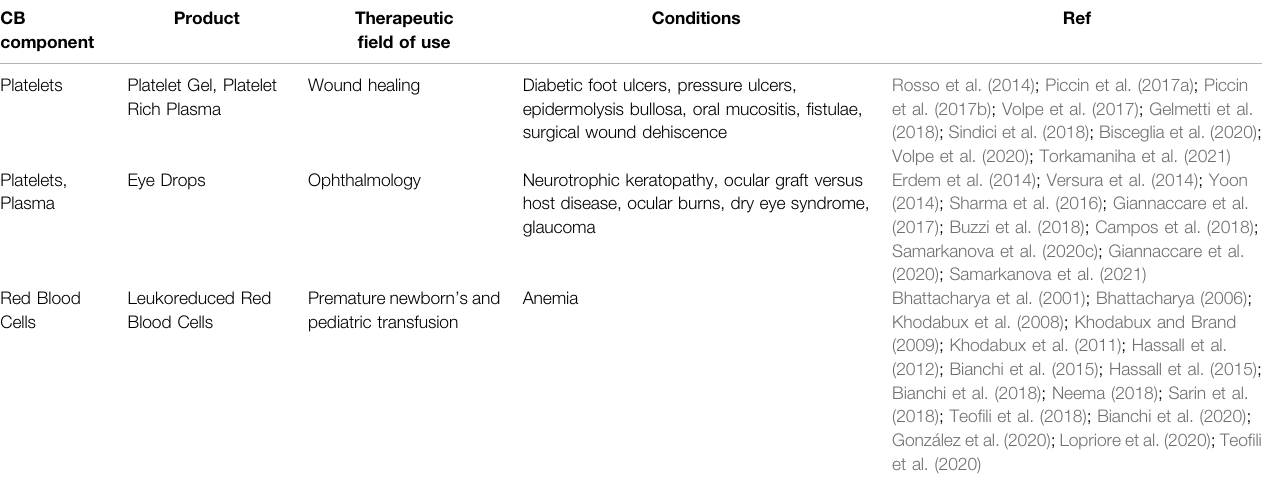
TABLE 1 | A selection of published reports on the clinical use of CB platelets, plasma and red blood cells in wound healing, ophthalmology, neonatal and pediatric